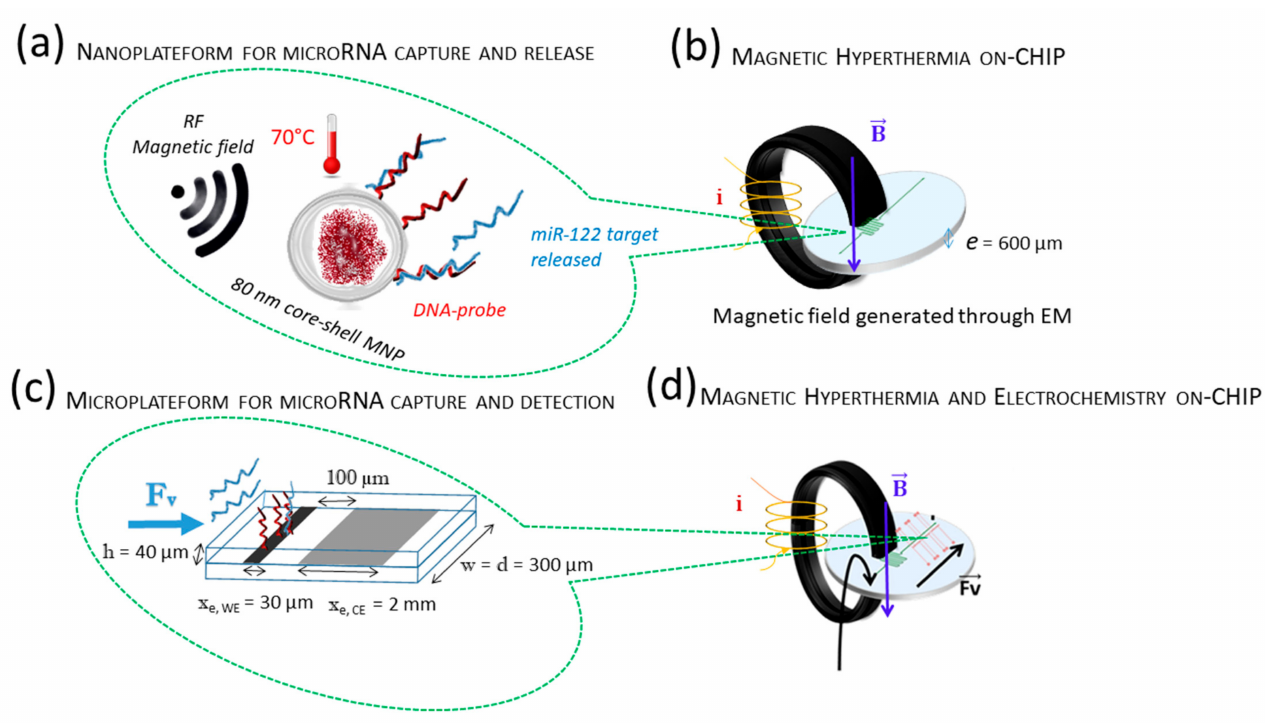
Figure 2. ( a ) Nanoplateform for microRNA release using functionalized core–shell magnetic nanoparticles (MNPs) and on-chip magnetic hyperthermia. ( b ) Schematic view of the localized magnetic hyperthermia through the ferrite